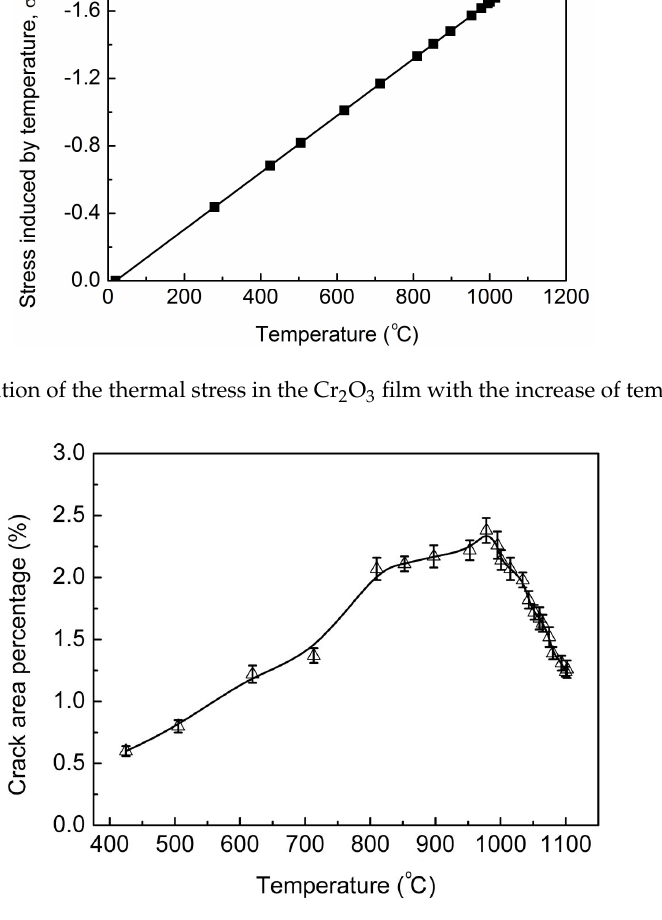
Figure 3. Variation of the crack area percentage on the Cr 2 O 3 film surface with the increase of temperature.